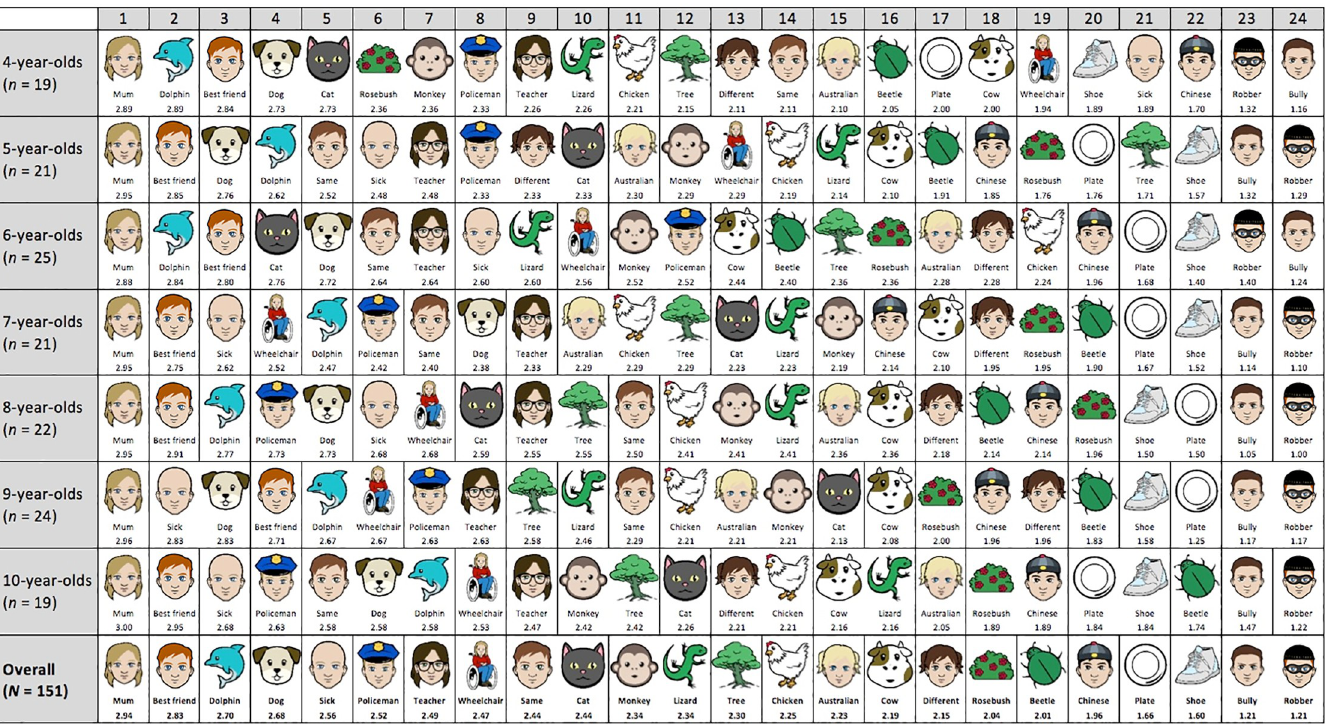
Fig 4. Children’s relative levels of moral concern for the 24 different entities across seven age groups (actual target stimuli depicted). The number below each target refers to a mean score, where ‘not caring at all’ responses were scored as 1, ‘caring a little’ responses were scored as 2, and ‘caring a lot’ responses were scored as 3 (range of possible means = 1–3). This is for ease of comparison only, as the ordinal logistic GLMMs treated these responses as non-linearly related categories. Note that targets with equal mean scores for a given age group are included in the same frame. Note also that the ‘best friend’ stimulus was either male or female, depending on how the child answered the question “is your best friend a boy or a